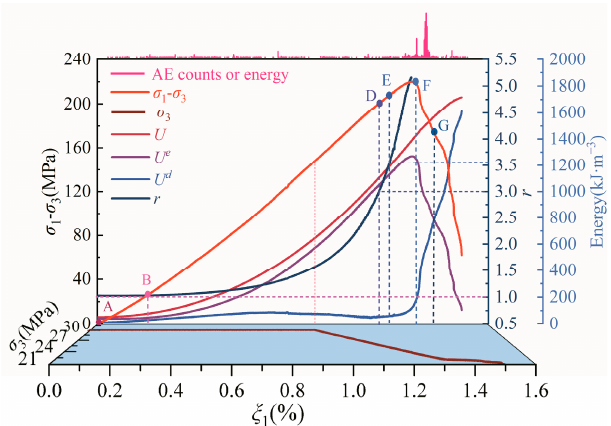
Figure 14. Damage evolution process of loading and unloading diorite.